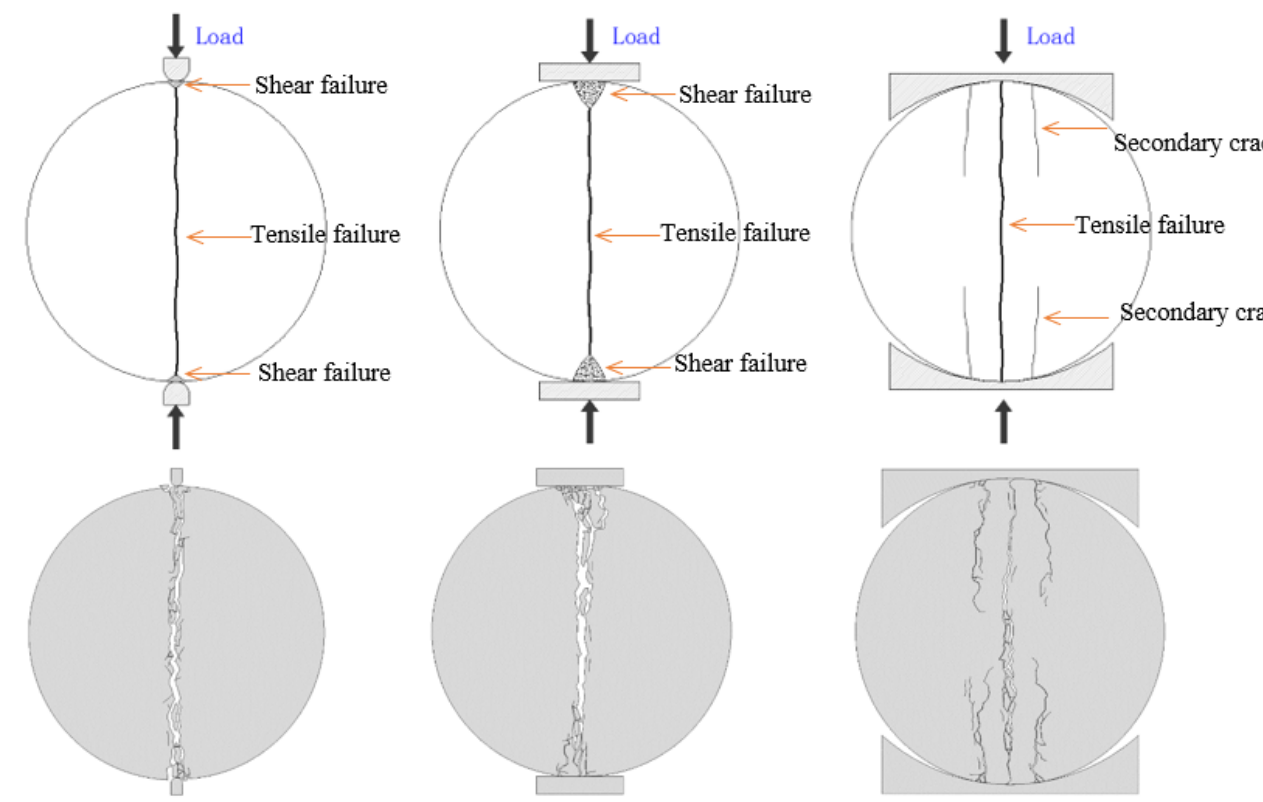
Figure 18. The failure mode transition of Brazilian disc test with different loading configurations.